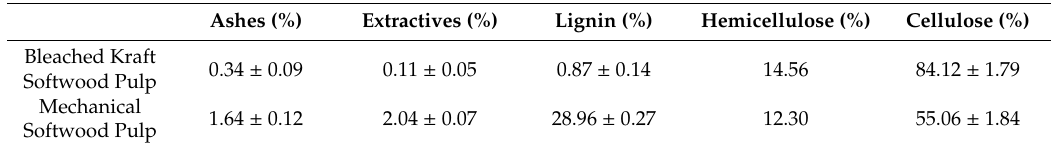
Table 1. Chemical composition of bleached Kraft softwood pulp